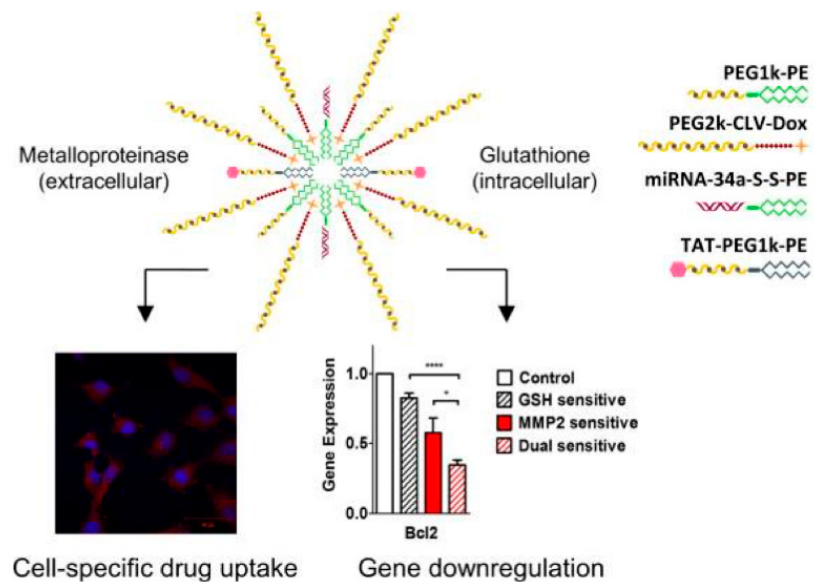
Figure 3. MMP-2 and glutathione sensitive polymeric nanoparticles used for co-delivery of DOX and miRNA-34a. Reproduced with permission from Salzano et al., Small; John Wiley and sons, 2016 [48]. * p ≤ 0.05, **** p ≤ 0.0001, n = 3, error bars represent mean ± SD.